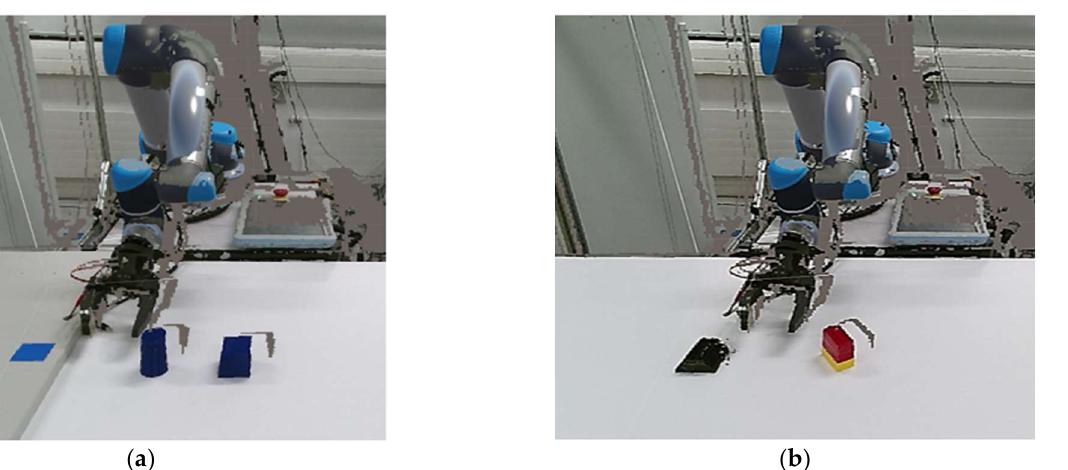
Figure 3. Overview of the MR subspace interface with the digital twin of the UR5 robot superimposed on the 3D Point Cloud of the physical UR5 robot in the MR environment. ( a ) The pick-and-place task of two cubical and cylindrical objects given a goal position with different heights; ( b ) the assembly task involved grabbing one LEGO subassembly from a predefined spot and stacking it onto a fixed LEGO base on the table.